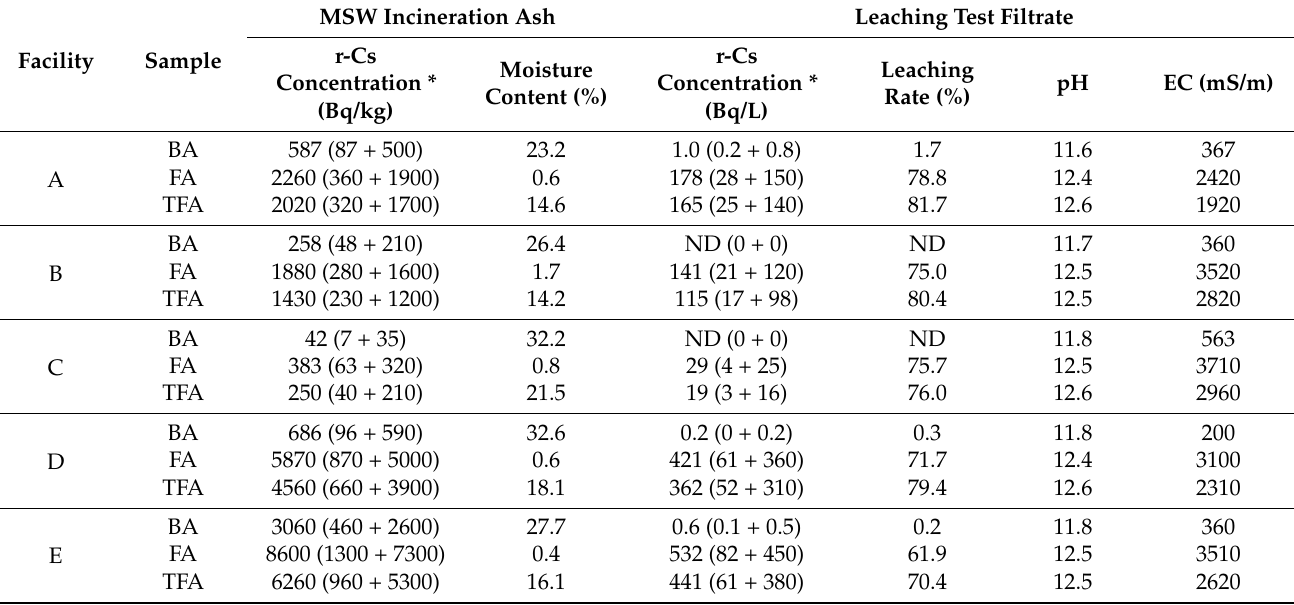
Table 1. Concentration and leaching of radioactive cesium (r-Cs) in August 2016.